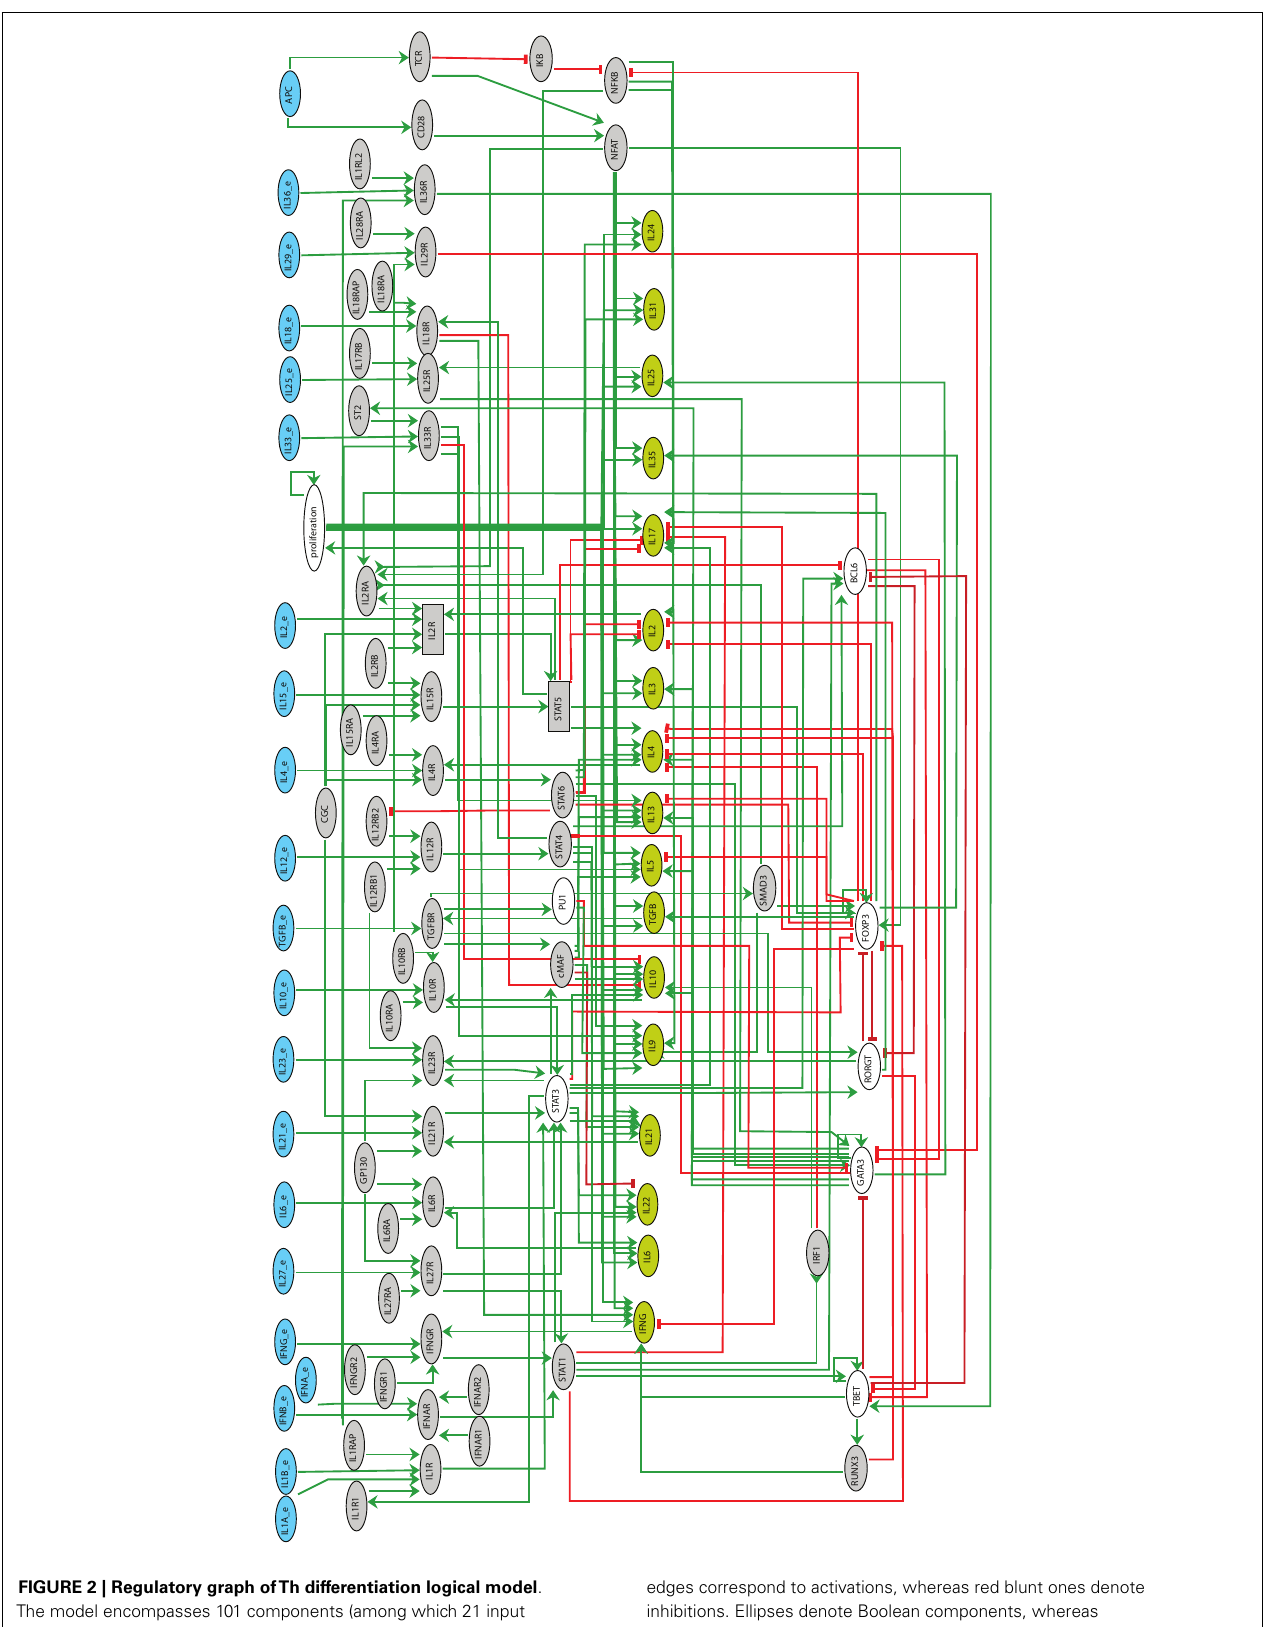
FIGURE 2 | Regulatory graph ofTh differentiation logical model . The model encompasses 101 components (among which 21 input nodes) and 221 interactions.The components denoting the inputs are in blue, those denoting the secreted cytokines in olive. Green